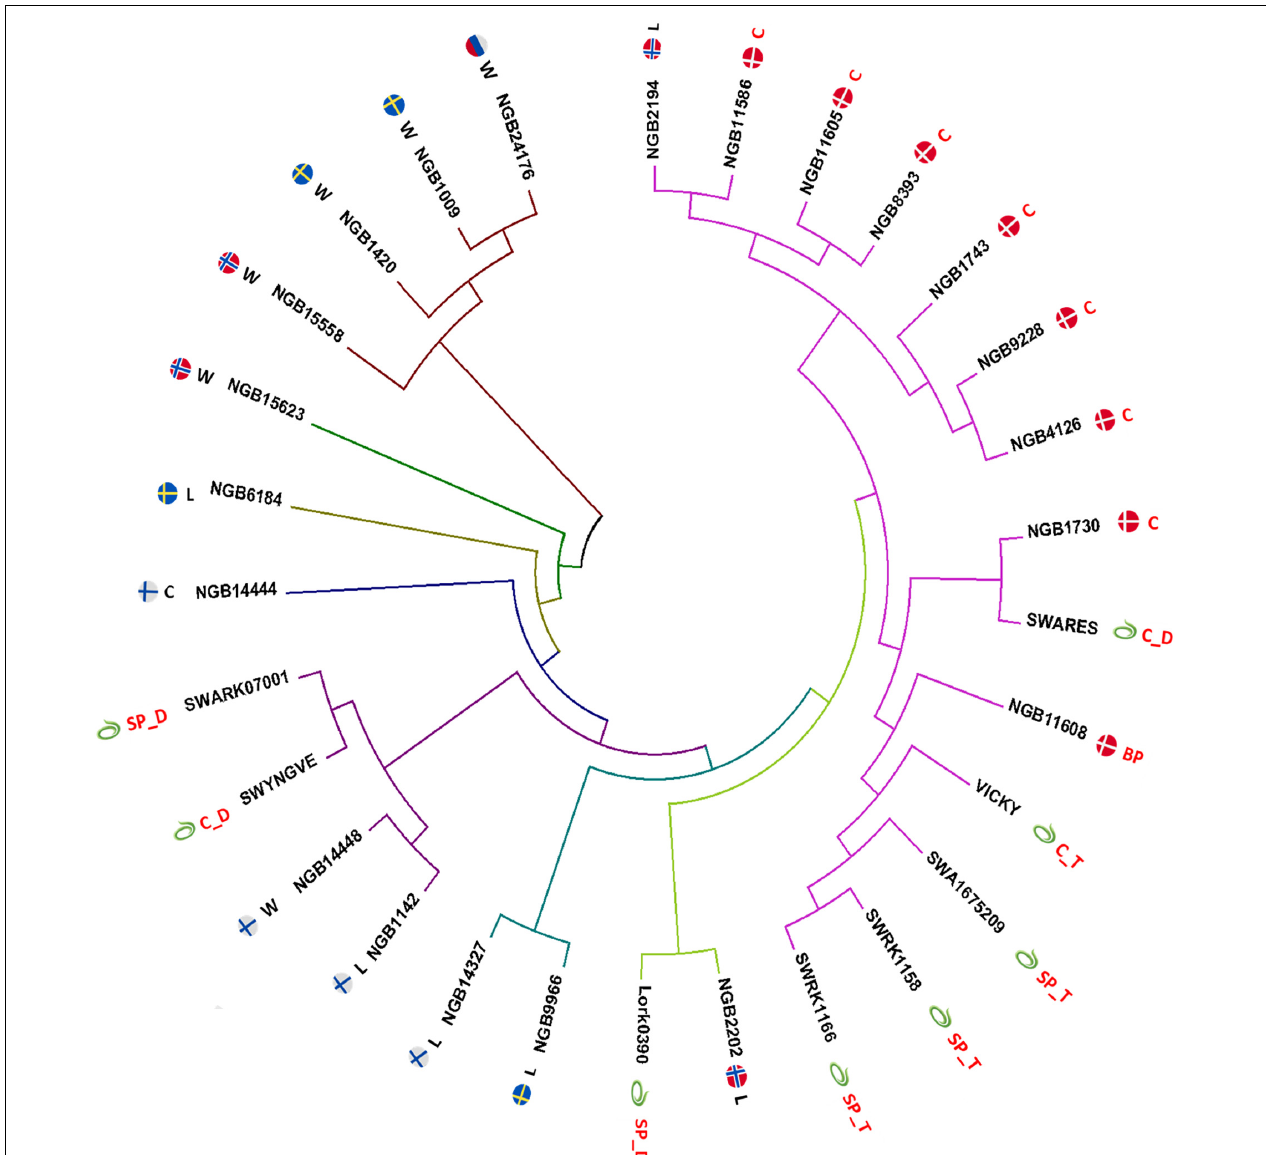
FIGURE 4 | A neighbor joining (NJ) tree constructed based on Nei’s unbiased genetic distance values of the 29 accessions with a fan layout and edges scaled to equal length. Each node is labeled with the accession name as well as an icon of the flag of its country of origin or the Lantmännen symbol. The letter abbreviations following the flag corresponds to the population type of the accession with W for wild population, L for landrace, C for cultivar, SP for synthetic population and BP for breeding population. The letter following the underscore (_) signifies the ploidy of the accession (if it is known) with D for diploid and T for